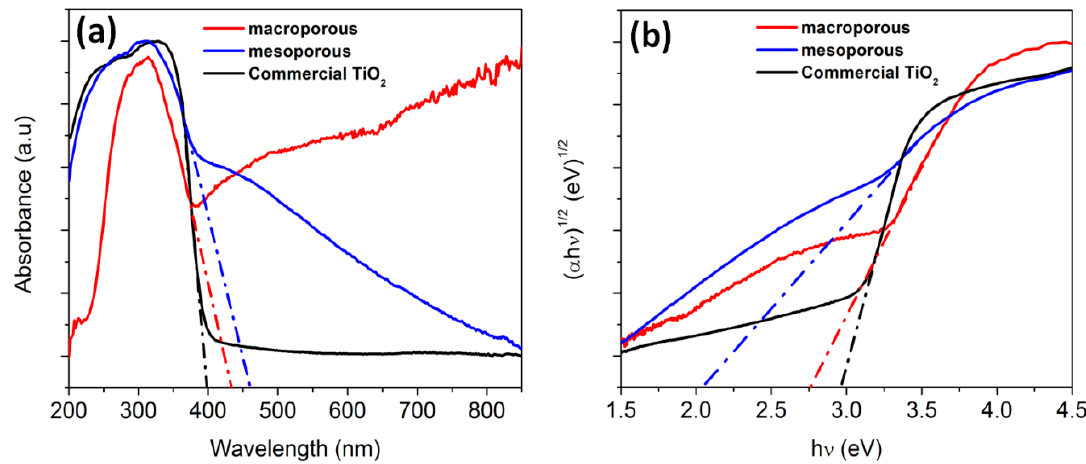
Figure 12. ( a ) UV-vis DRS spectra; ( b ) Tau plot: Namely ( α h ν ) 1/2 vs. h ν of macro/mesoporous nanocomposites and commercial TiO 2 .